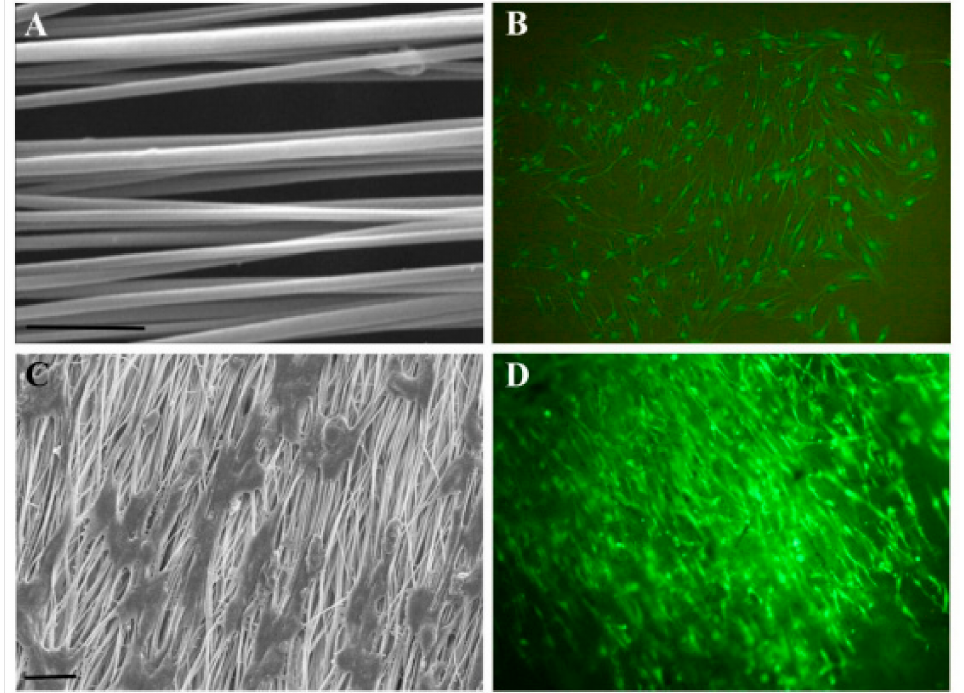
Figure 10. Effect of guidance cues on the alignment of OEC. ( A ) Aligned SWCNT/PLLA nanofibers used as the substratum for OEC, scale bar = 10 µ m; ( B ) OEC grown on culture plates showing random orientation, magnification 100 × ; ( C ) SEM micrographs of OEC aligned on nanofiber SWCNT/PLLA scaffolds, scale bar = 2 µ m; ( D ) Fluorescence image of aligned OEC grown on SWCNT/PLLA nanofibrous scaffolds, magnification 100 × . Reprinted with permission from EXCLI Journal